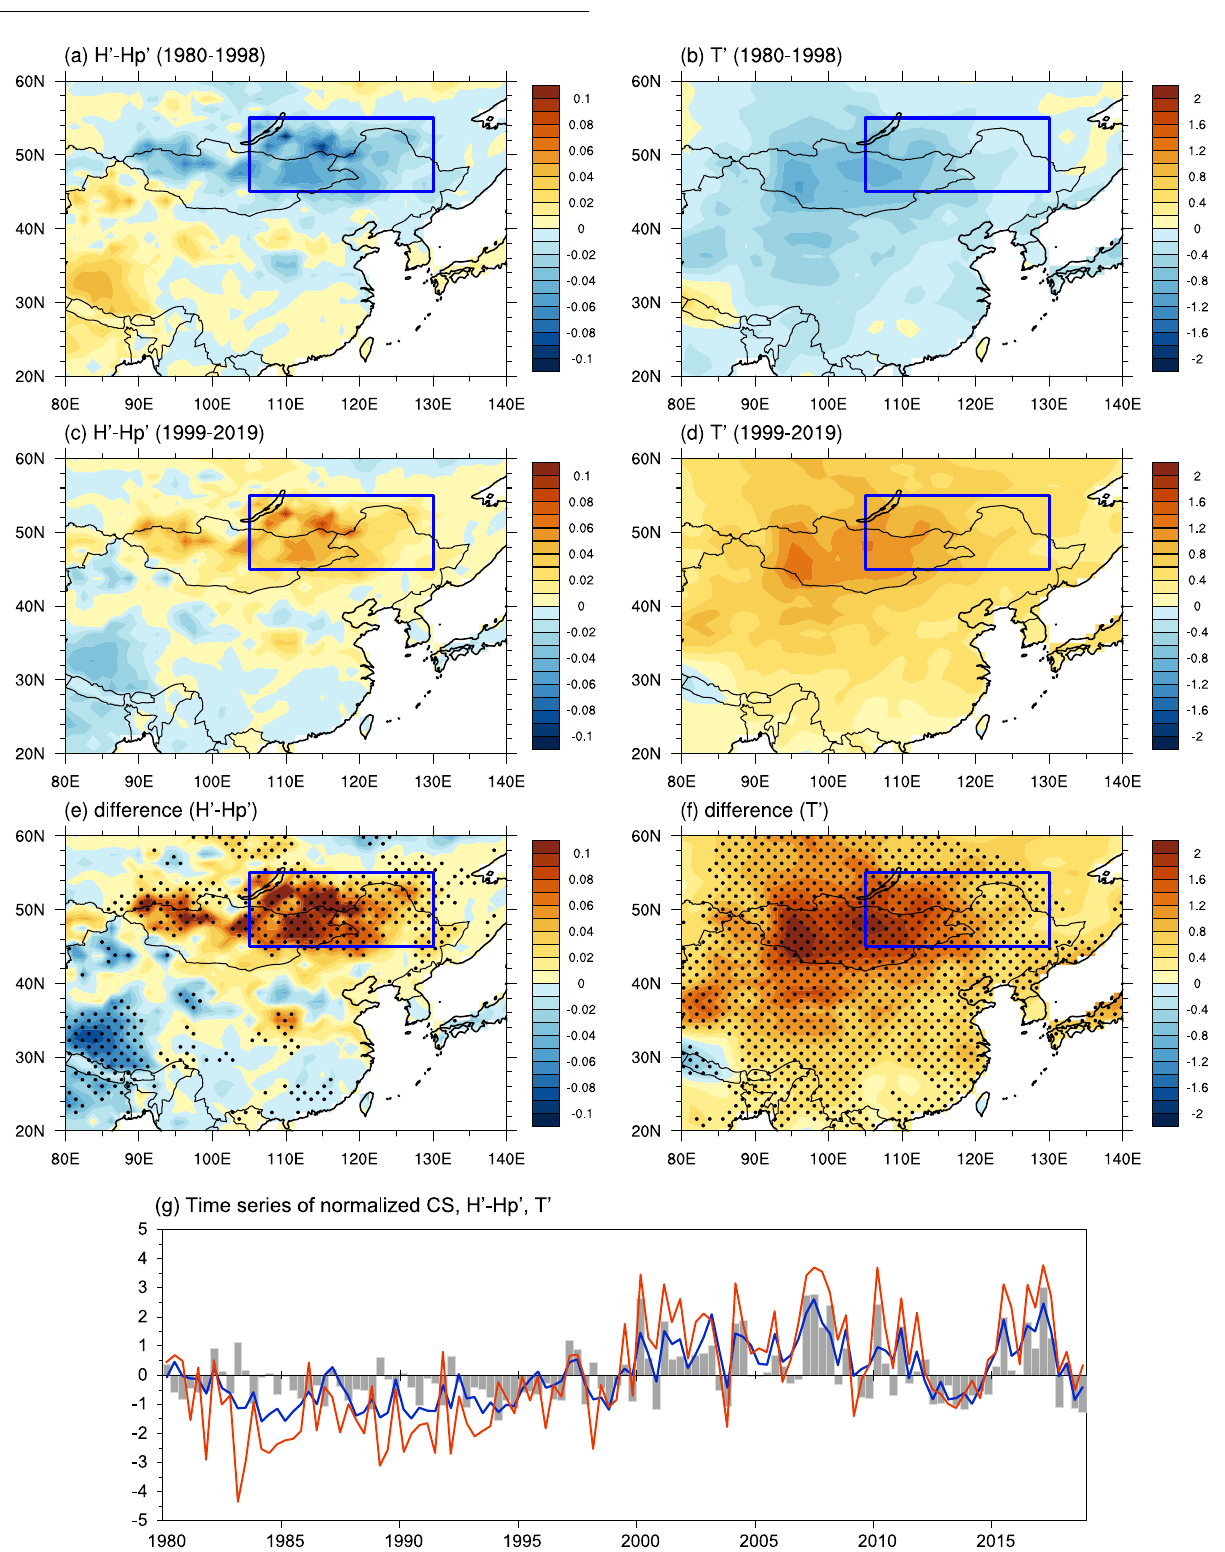
Fig. 2 Composite of energy and temperature anomalies and its normalized monthly time series during summer. Energy anomalies ) and temperature anomalies ( T 0 ) during the period ( a , b ) 1980 – 1998, ( c , d ) 1999 – 2019, and ( e , f ) its differences over East Asia, ( H 0 (cid:2) H 0 p respectively. The dots in ( e ) and ( f ) denote the 95% con fi dence level based on the Student ’ s t test. g Monthly time series of normalized soil (orange line), and T 0 (blue line) in summer (June-July-August). The moisture-temperature coupling strength index (CS) (gray bars), H 0 (cid:2) H 0 p regions contributing to the time series are marked in blue boxes [105 – 130°E, 45 – 55°N] in ( a – f